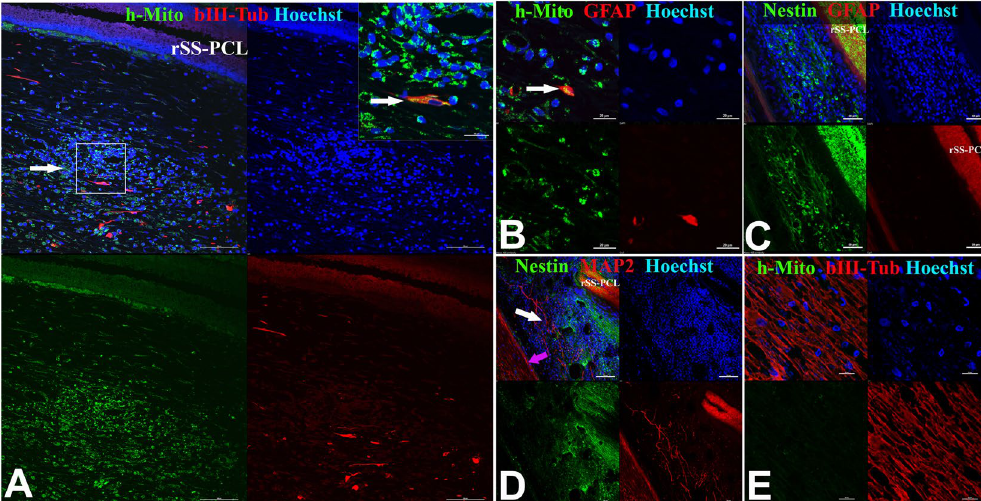
Figure 9. Immunofluorescence analysis of the spinal cord of a rhesus macaque at the site of implantation of the SPRPix matrix with human drNPC. ( A ) Representative low magnification image of the site of drNPC-SPRPix implantantation showing expression of human specific mitochondrial antigen (h-Mito) and β III-tubulin (arrow) On the right: high magnification of the boxed area demonstrating co-localization of h-Mito and β III-tubulin. ( B ) Rare example of colocalization of h-Mito with GFAP (arrow) at the site of transplantation. ( C ) Staining with human specific anti-Nestin and GFAP revealed numerous nestin-positive cells and the lack of astroglial reaction/differentiation. ( D ) Representative image of human specific anti-Nestin and MAP2. The white arrow points at the long MAP2-positive neurites derived from the human cells. The purple arrow shows the border of the spinal cord. ( E ) Control staining of naive spinal cord tissue demonstrated lack of h-Mito signal. Cell nuclei in all the images are stained with Hoechst (blue). Notations: rSS-PCL-spidroin- polycaprolactone scaffold; SC – spinal